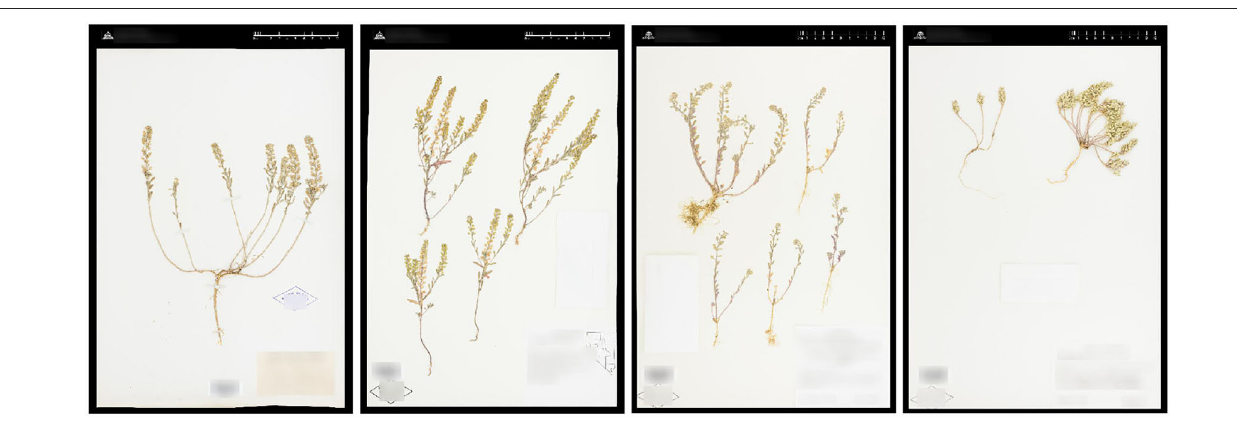
FIGURE 5 | Example of visually similar images from different Alyssum species (Brassicaceae): A. alyssoides (L.) L., A. desertorum Stapf, A. simplex Rudolphi, A. szovitsianum Fisch. and C. A. Mey.